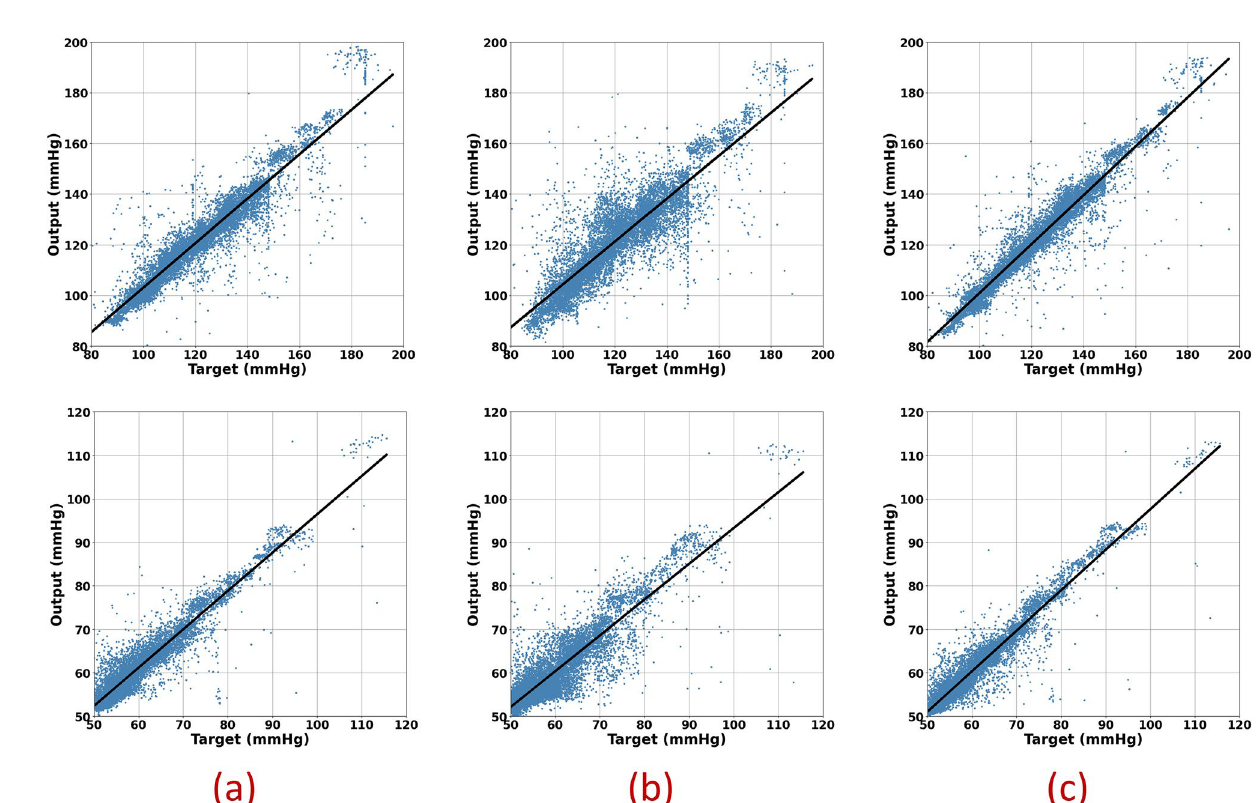
Figure 7. Regression plots for all 3 different models: ( a ) 1D_CNN, ( b ) 2D_CNN, ( c ) Concat_CNN. Plots in the upper row are related to systolic blood pressure and those in lower row are related to the diastolic blood